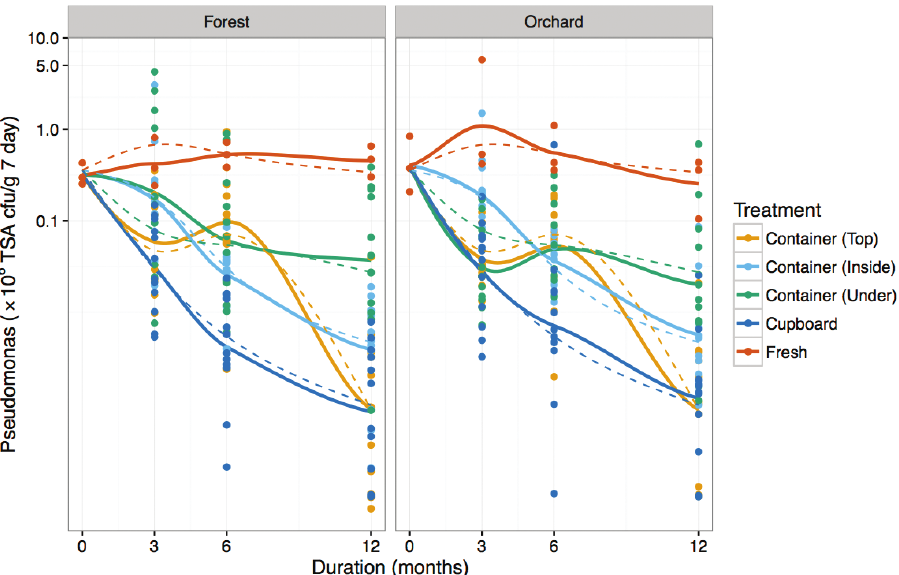
Figure 2. Scatterplot of mean Pseudomonas spp. counts (cfu/g) at 0, 3, 6 and 12 months measured in soil recovered from on, in and under four sea containers and inside four cupboards. Solid lines show the smoothed means and dashed lines predictions from the preferred